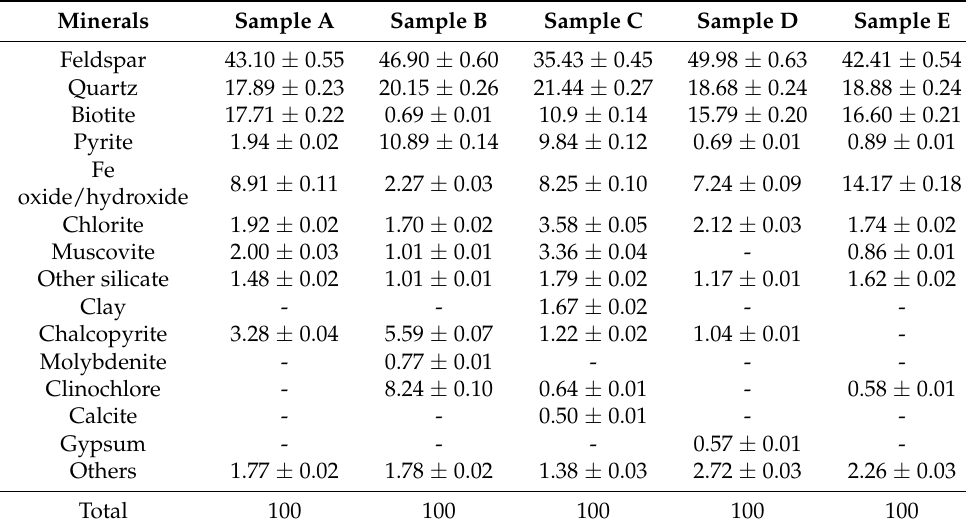
Table 5. Mineral composition for each ore sample